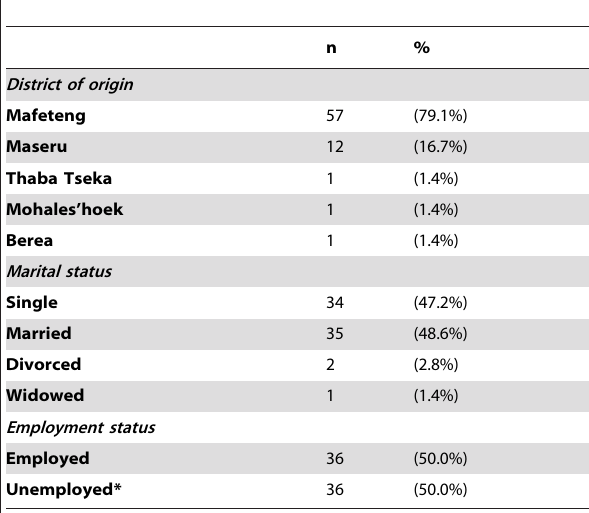
Table 1. Demographics of clients who tested HIV-positive at the Mafeteng VMMC site